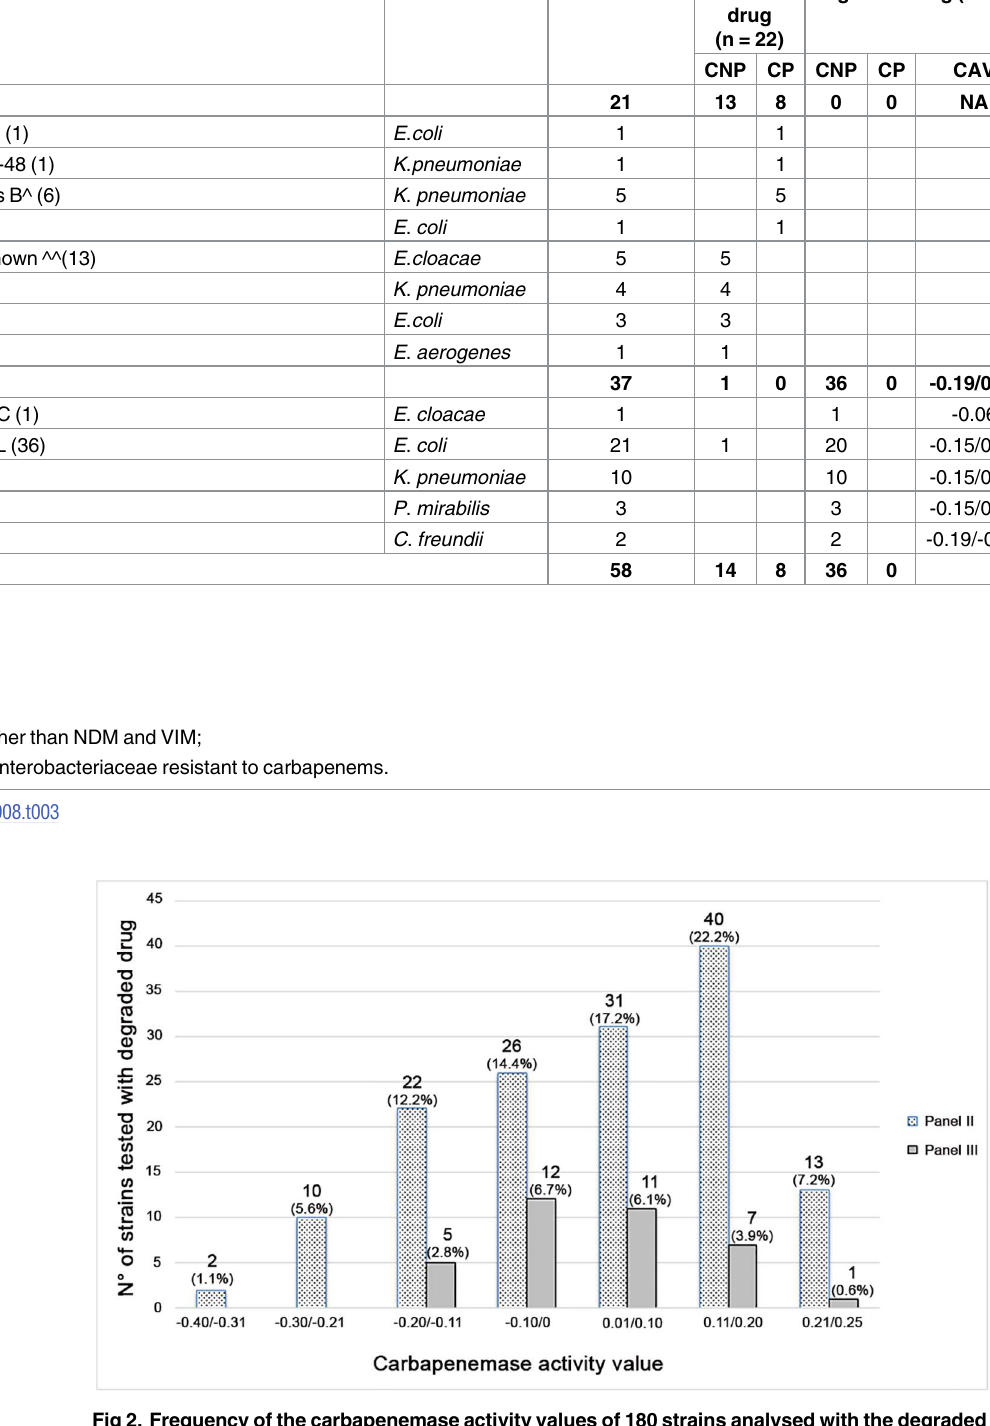
Fig 2. Frequency of the carbapenemase activity values of 180 strains analysed with the degraded drug. In brackets, the percentage of each frequency range calculatedon the total of 180 strains are indicated.